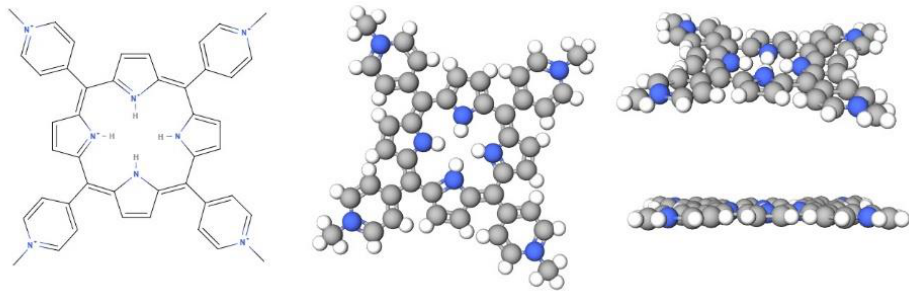
Figure 1. 3D structure of 5,10,15,20-tetrakis (1-methyl-4-pyridinium) porphyrin (TMPyP) that exem- plifies the planarity of the molecule.